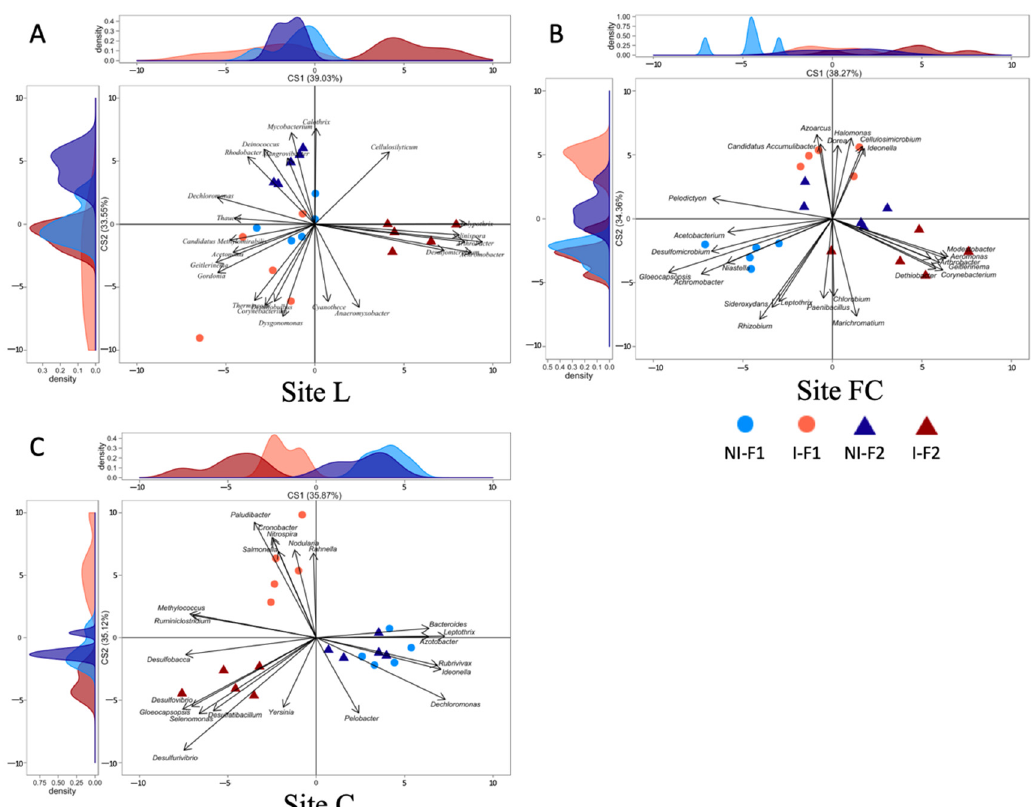
Figure 2. Effect of inoculation level of A. lipoferum CRT1 on the composition of the diazotroph community ( nifH ) as indicated by between-class analyses (BCA) studied at three field sites L ( A ), FC ( B ), and C ( C ). F1 (circles) corresponds to the peat matrix used to coat seeds with low inoculant concentration, using data originating from [21], and in F2 (triangles), A. lipoferum CRT1 was used at higher inoculant concentration. NI (blue) and I (reddish) correspond, respectively, to non-inoculated and inoculated conditions. Curves on top and left represent, respectively, the sample distribution on abscissa and ordinate axes. Vectors on plot represent the bacterial genera contributing the most to sample distribution.